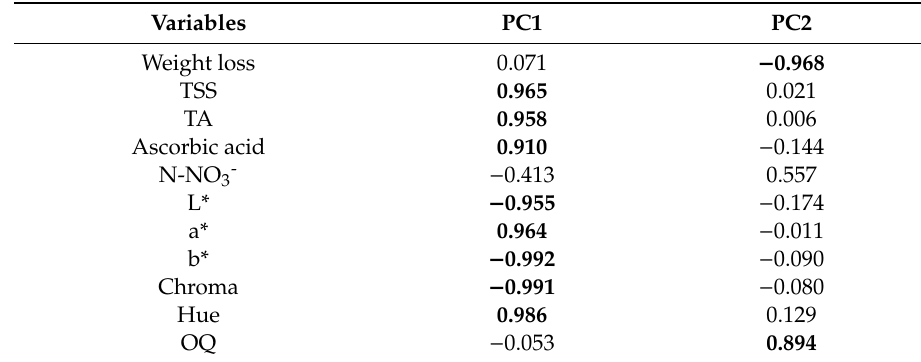
Table 6. Correlation of variables to the factors of the principal components analysis (PCA) based on factor loadings. Variables PC1 PC2